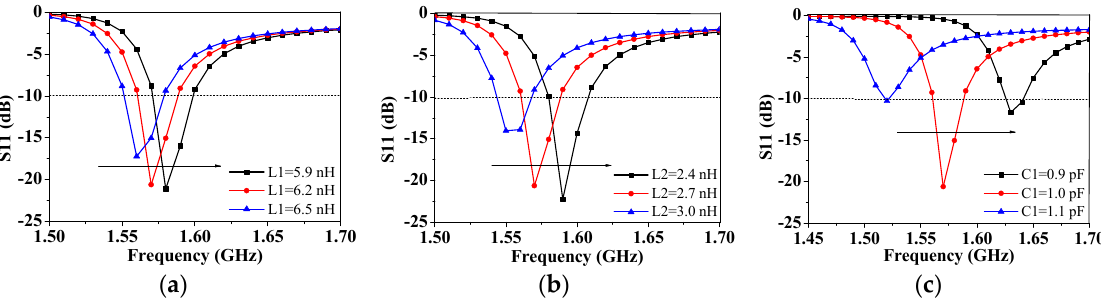
Figure 4. Simulated S11 with different values of the matching network: ( a ) L1, ( b ) L2 and ( c ) C1.